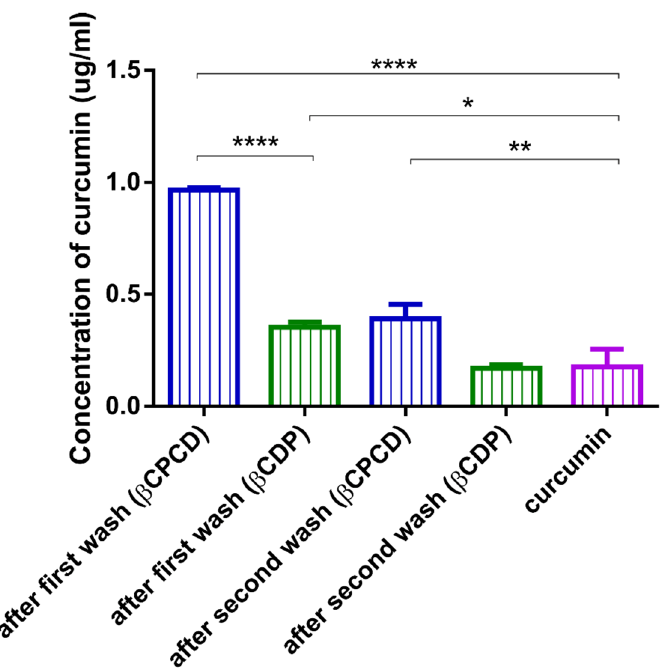
Figure 2. After incubation of excess amounts of curcumin with 10.0 m/m % β CDP and β CPCD solutions for 24 h, the supernatant was removed and the solid sedimented phase was further washed and incubated with purified water in two washing steps for 24 h in each step. The solubilized curcumin in the supernatant after each wash was determined and compared to the curcumin dissolved without cyclodextrin polymers (data are presented as means ± SD, n = 3. Labels of the significant differences are the following: **** p < 0.0001, ** p < 0.01, * p < 0.05).